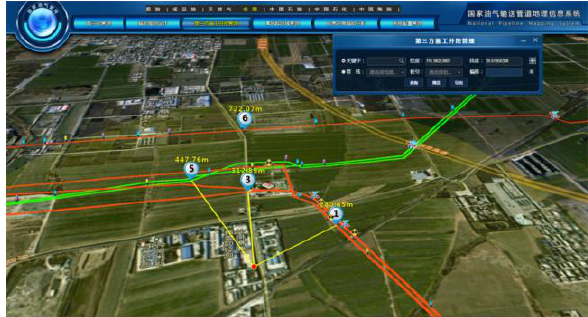
Figure14 . National Pipeline Mapping System based on multi- temporal